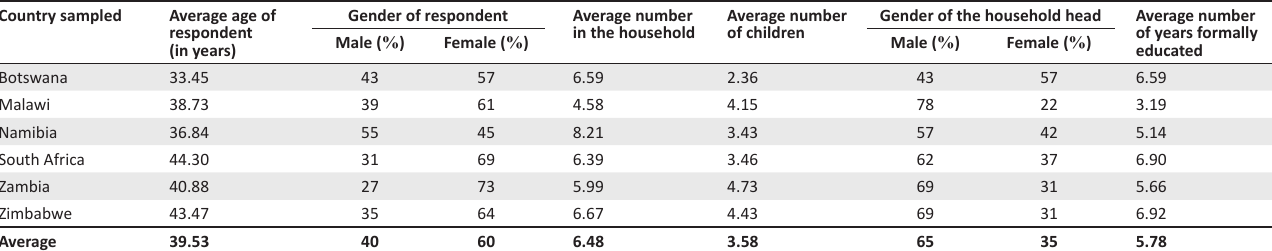
TABLE 2: Summary of respondents’ demographic characteristics.